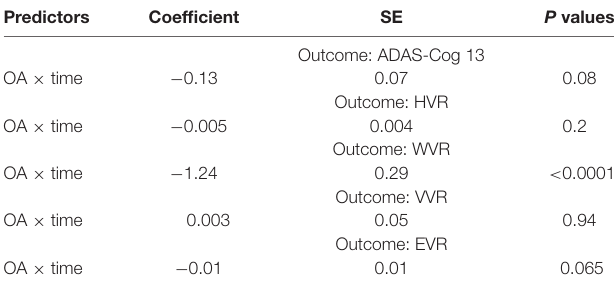
TABLE 2 | Association of OA status with changes in ADAS-Cog 13 and neurodegenerative markers over time among non-demented older people. Predictors